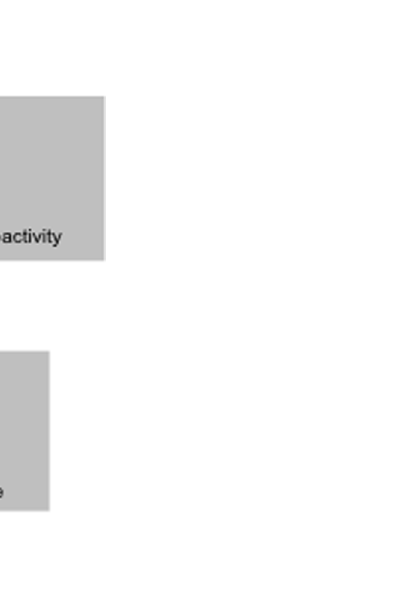
Figure 3. Components of the INTERGROWTH-21 st Neurodevelopment